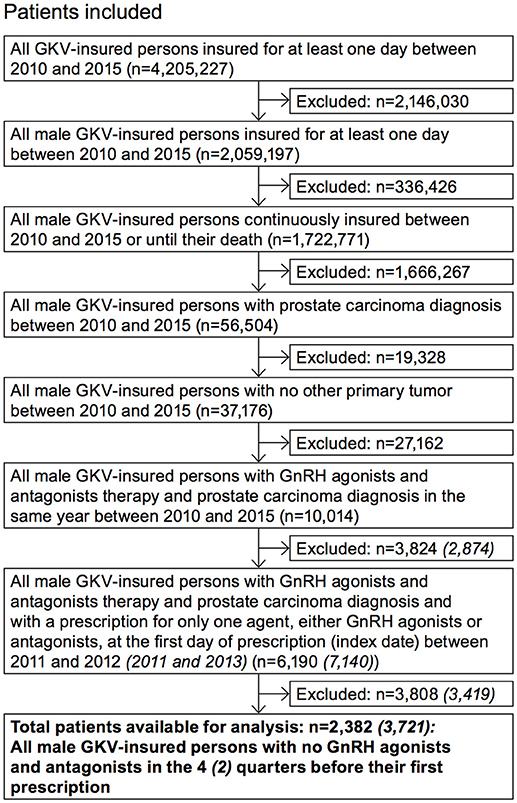
Selection of study population. In brackets: adjusted population.